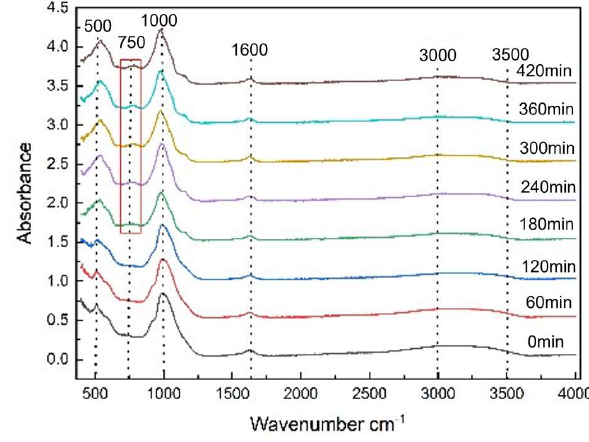
Figure 8. FTIR spectra of the precipitates at different reaction times.